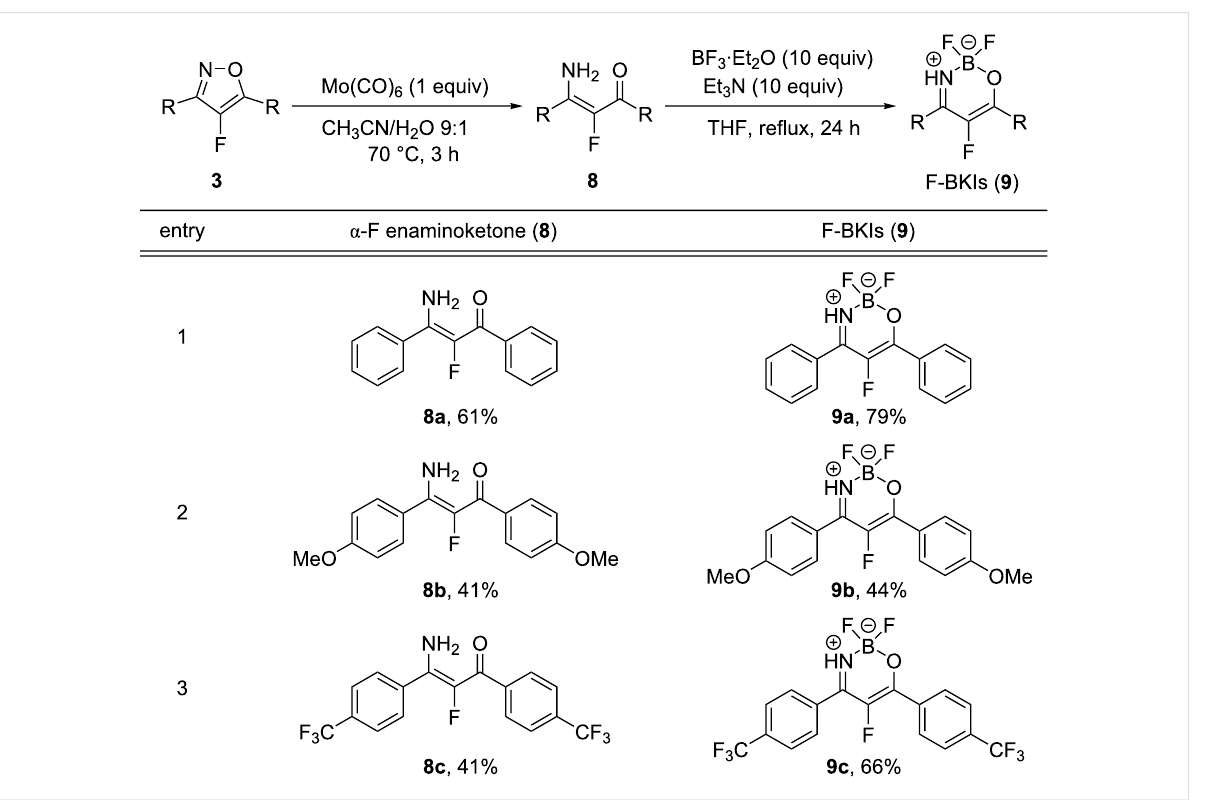
Scheme 6: Ring-opening reaction of 4-fluoroisoxazoles 3 and their conversion into F-BKIs 9 (yields refer to isolated